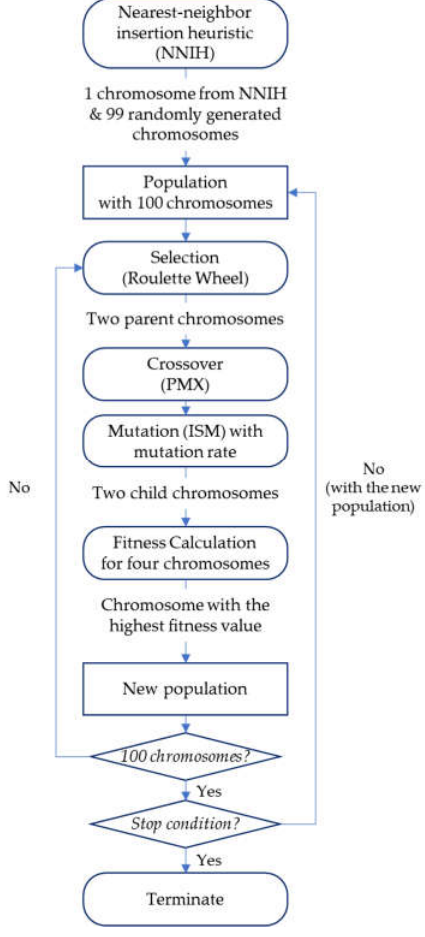
Figure 6. Overall procedure of the proposed heuristic approach.